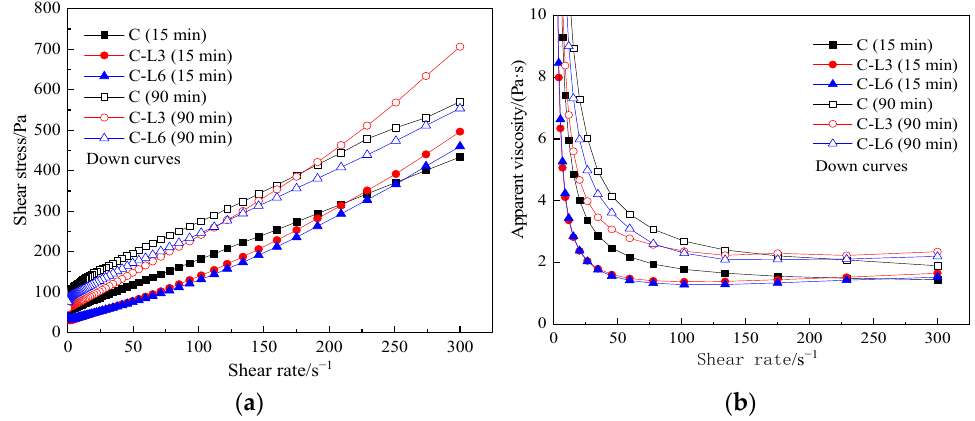
Figure 4. Rheological curves of C-LP paste. ( a ) shear stress vs. shear rate, ( b ) apparent viscosity vs. shear rate.